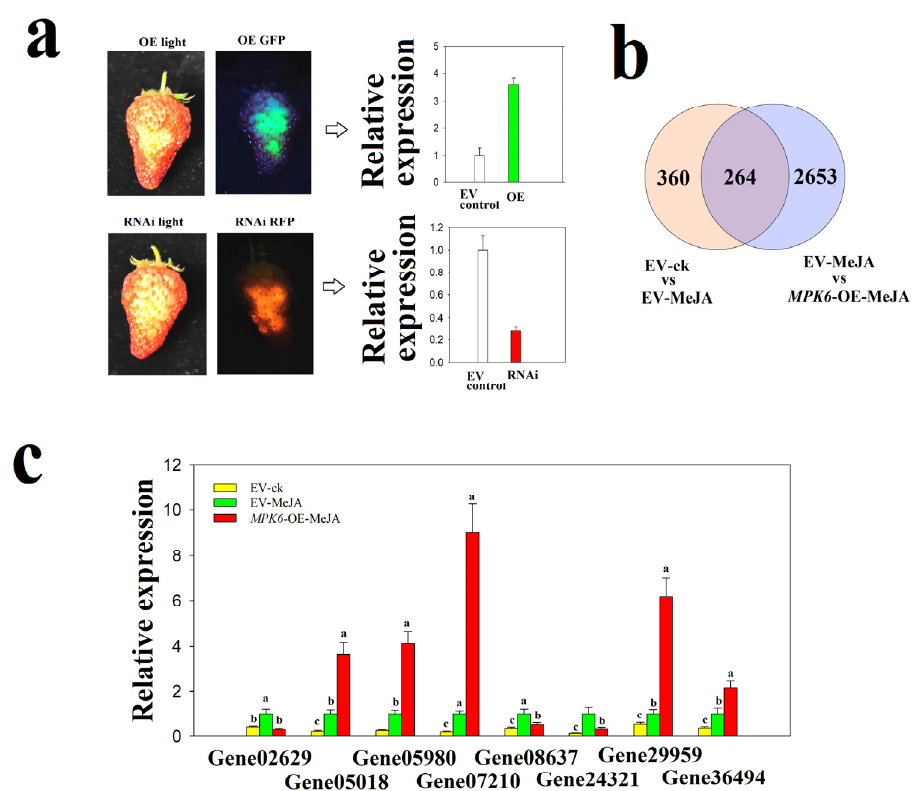
Figure 7. Expression pattern of genes regulated by FaMPK6 in the jasmonic acid (JA) signaling pathway. ( a ) the upper left image shows the pattern of FaMPK6 over-expression, as indicated by green fluorescent protein (GFP) image analysis of a FaMPK6: GFP fusion protein and qRT-PCR analysis of the FaMPK6 expression pattern in these fruit; the lower left image shows FaMPK6 RNAi down-regulation, as indicated by red fluorescent protein (RFP) image analysis of a FaMPK6 RNAi construct carrying the RFP gene driven by 35S promoter and qRT-PCR analysis of the FaMPK6 expression pattern in these fruit. ( b ) Venn diagram showing the expression pattern of genes regulated by methyl jasmonate (MeJA) and FaMPK6. ( c ) qRT-PCR verification of several genes controlled by FaMPK6 in the JA signaling pathway. Detached fruit at the LG stage were transiently transformed with A. tumefaciens carrying an empty vector, FaMPK6 -OE or RNAi constructs. On day 4 after transformation, RNA-seq analysis, imaging and qRT-PCR analysis were performed. Error bars represent the mean ± SD of three biological replicates. Significant difference in different treatment for each gene is indicated by different letters ( p < 0.05).